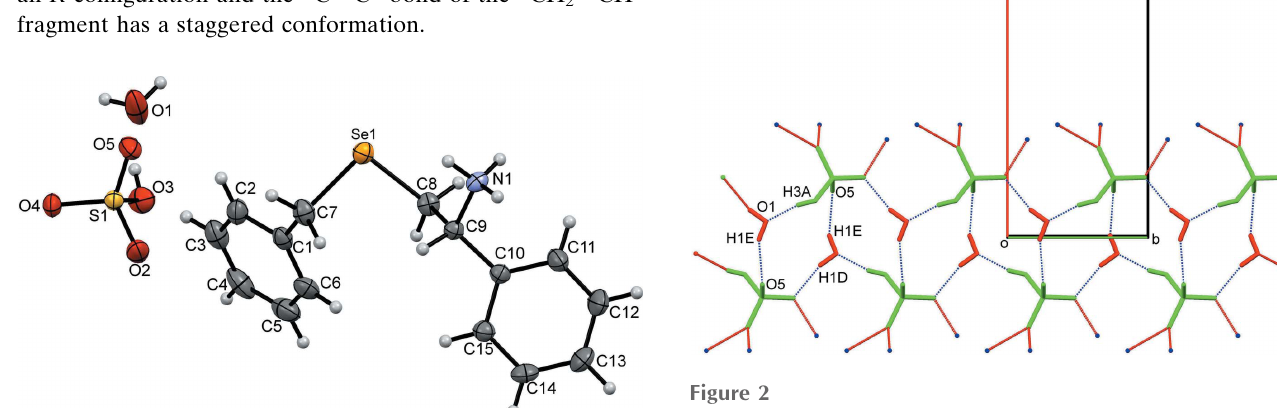
Figure 2 A partial view along the c axis of the crystal packing of the title salt, showing the propagation of the one-dimensional tape along the b -axis direction. The various intermolecular interactions (Table 1) are shown as dashed lines. Colour key: green, anions; red, water; blue spheres, cations.